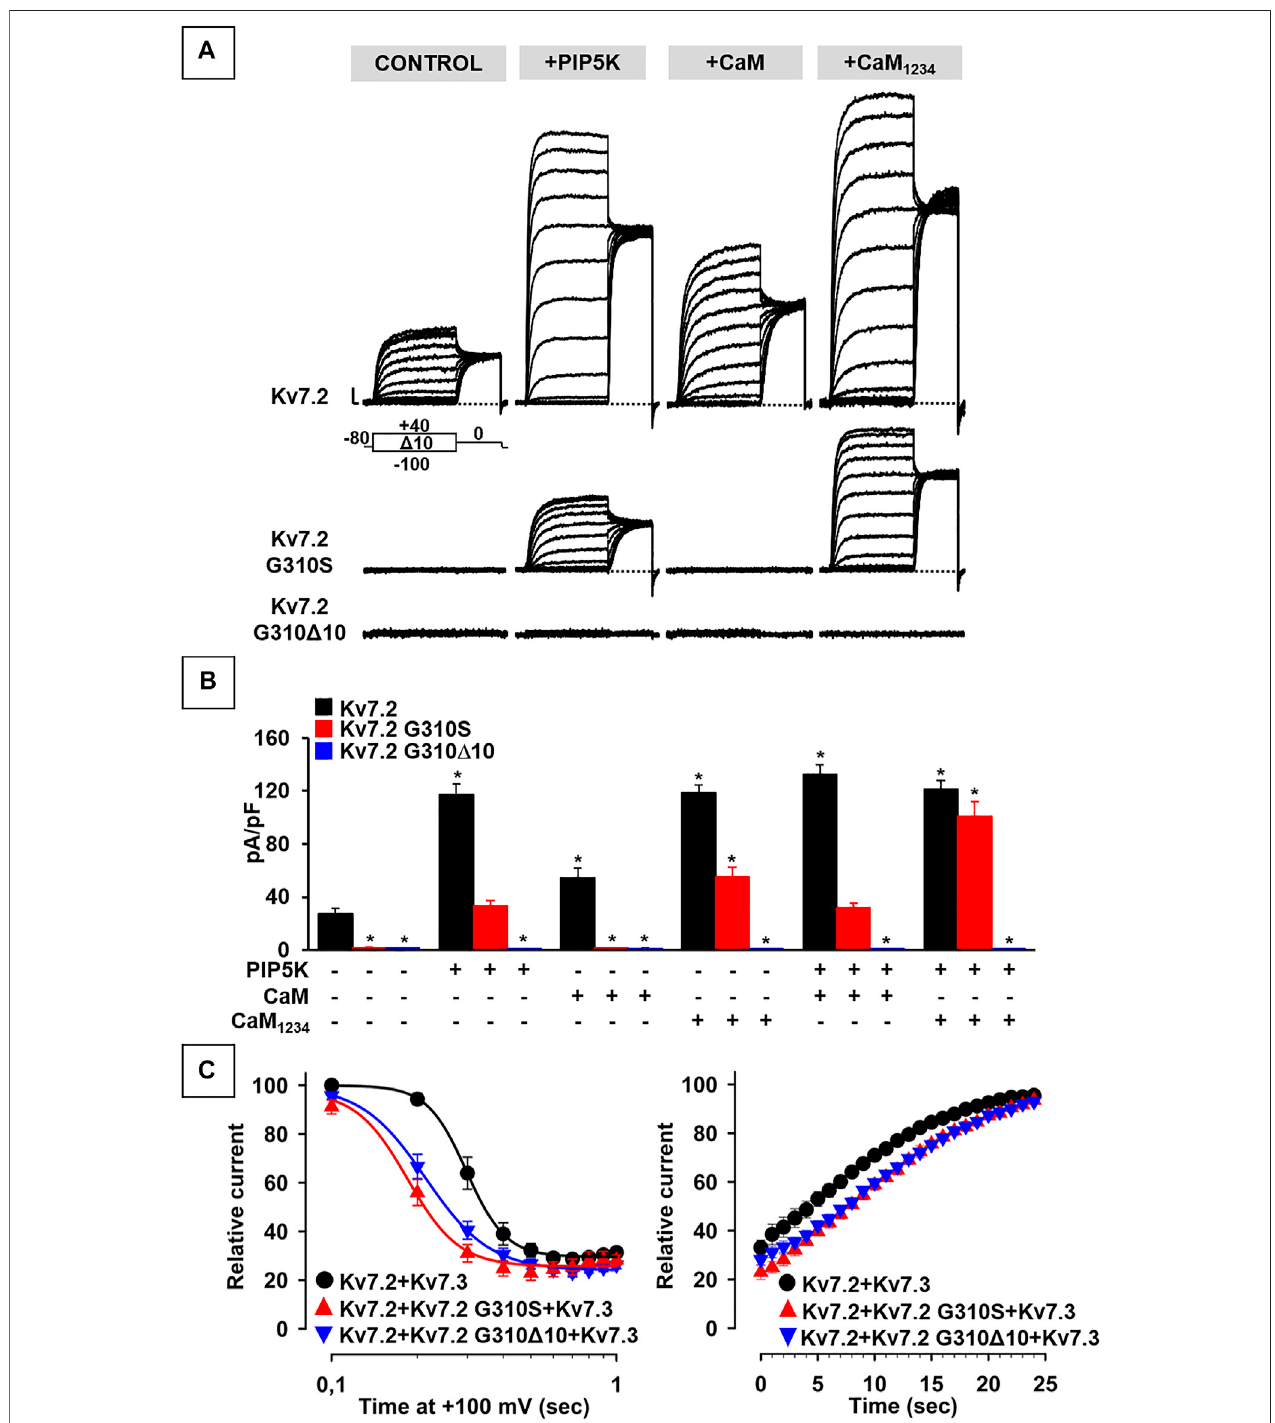
FIGURE 4 | Functional study of the modulation of Kv7.2 G310S or Kv7.2 G310 Δ 10 subunits by PIP 2 and calmodulin. (A,B) Representative traces (A) and quanti fi cation (B) of currents measured in CHO cells co-expressing homomeric wild-type or mutant Kv7.2 subunits with PIP5K, CaM, and/or CaM 1234 , as indicated. * = p < 0.05 versus Kv7.2. (C) Time-dependence of current decrease (left panel) and recovery (right panel) of currents measured in CHO cells co-expressing the indicated channels with DrVSP.